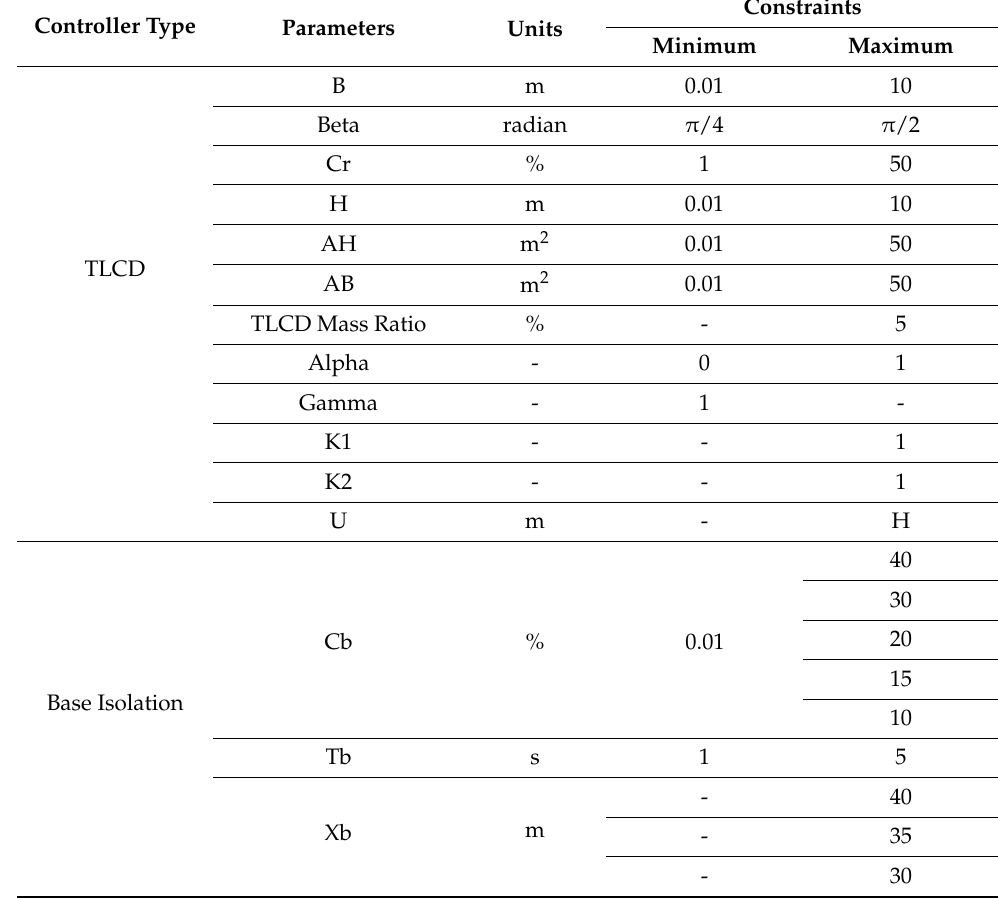
Table 2. Constraints of BI and TLCD’s